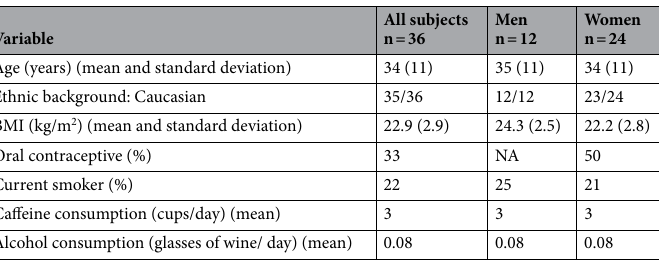
Table 1. Characteristics of the study population. BMI body mass